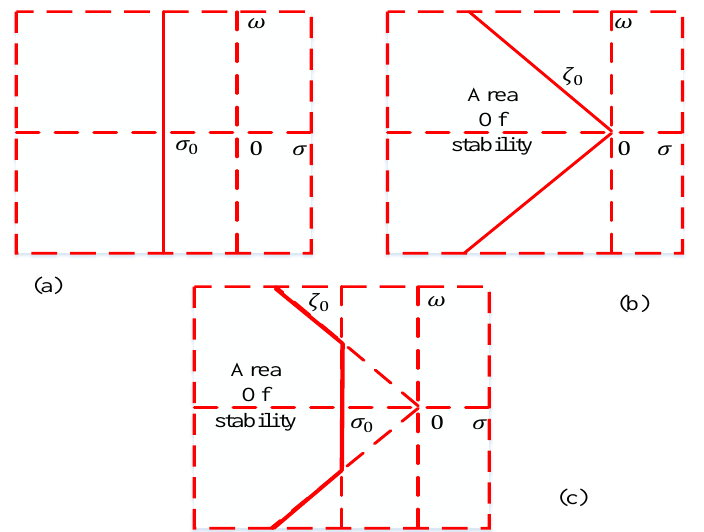
Figure 23. Approaches for objective function formulation: ( a ) formulation based on damping factor, ( b ) formulation based on damping ratio, ( c ) formulation based on both damping factor and damping ratio (D-shape) [28].